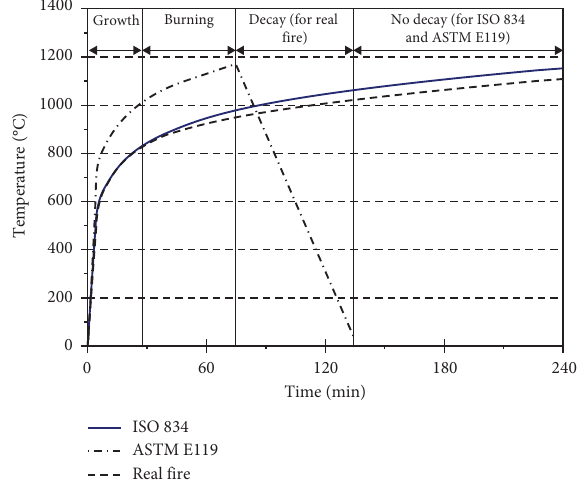
Figure 3: A comparison of real fire time-temperature curve with standard time-temperature fire curve (ASTM E119 and ISO 834)